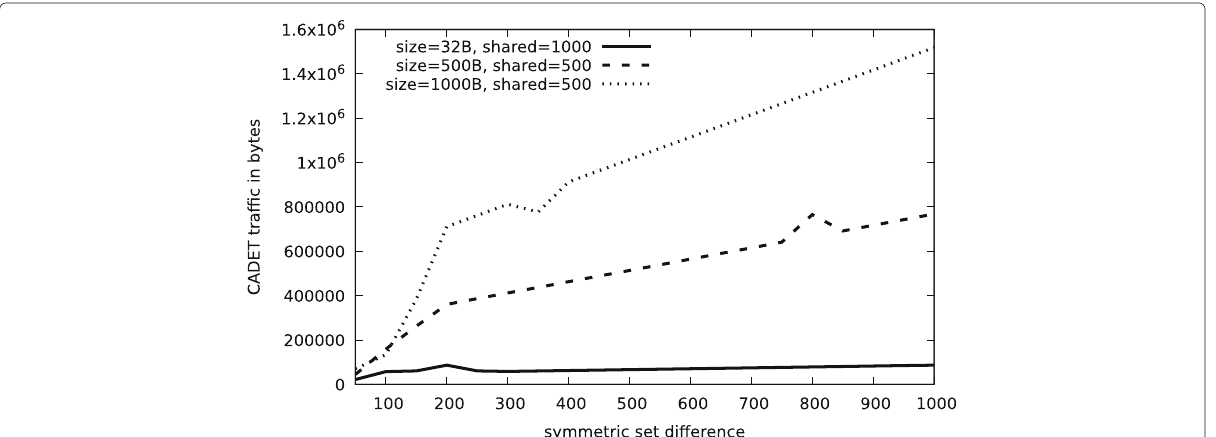
Fig. 5 CADET traffic for the SET service in relation to symmetric difference at the boundary between IBF and full set transmission. Note that we did cherry-pick runs for this graph. Our goal is to illustrate how the curves evolve with regard to different thresholds between IBF and full set transmission. We also wanted to show how significant deviations in set difference estimates generated by the strata estimator can have a minor impact on